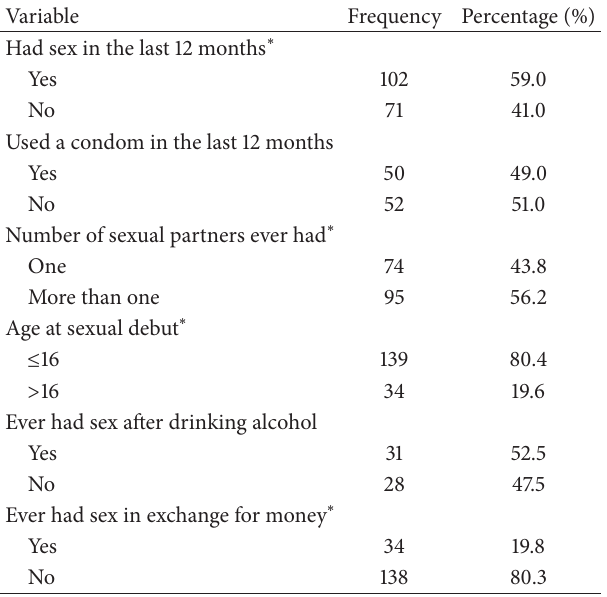
Table 3: Sexual behaviors of one hundred and seventy-four students who were sexually